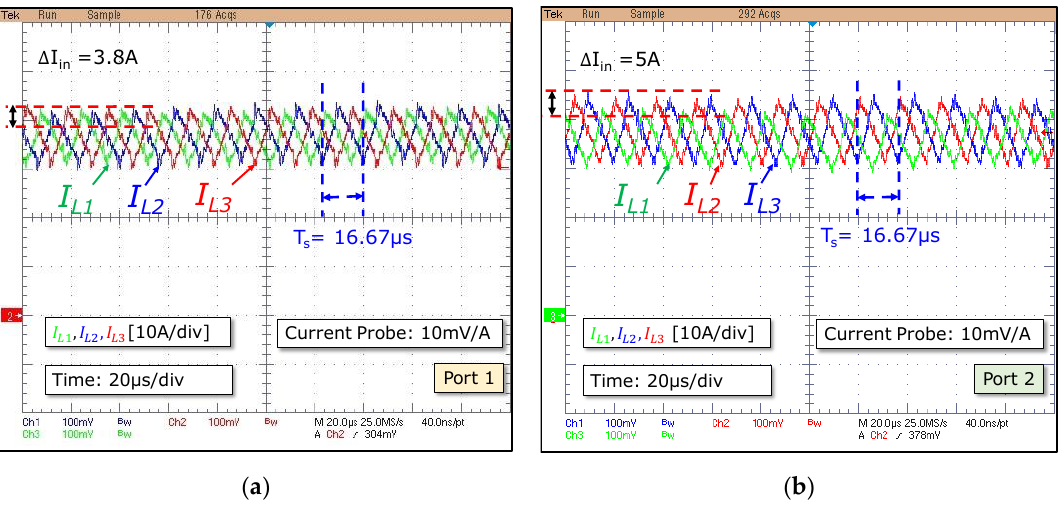
Figure 14. Experimental waveforms of three-phase interleaved inductor currents at 27 kW (V in = 250 V, V O = 395 V) ( a ) port 1 with L = 175 µH; ( b ) port 2 with L = 145 µH.